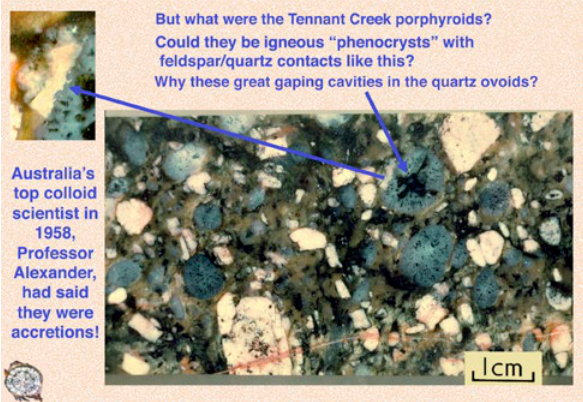
Figure 19. This observation is readily explained as the contact between two soft gelatinous substances such as clay and silica gel. The fragmentation of the feldspars and syneresis in the quartz ovoids confirm their accretionary origin.